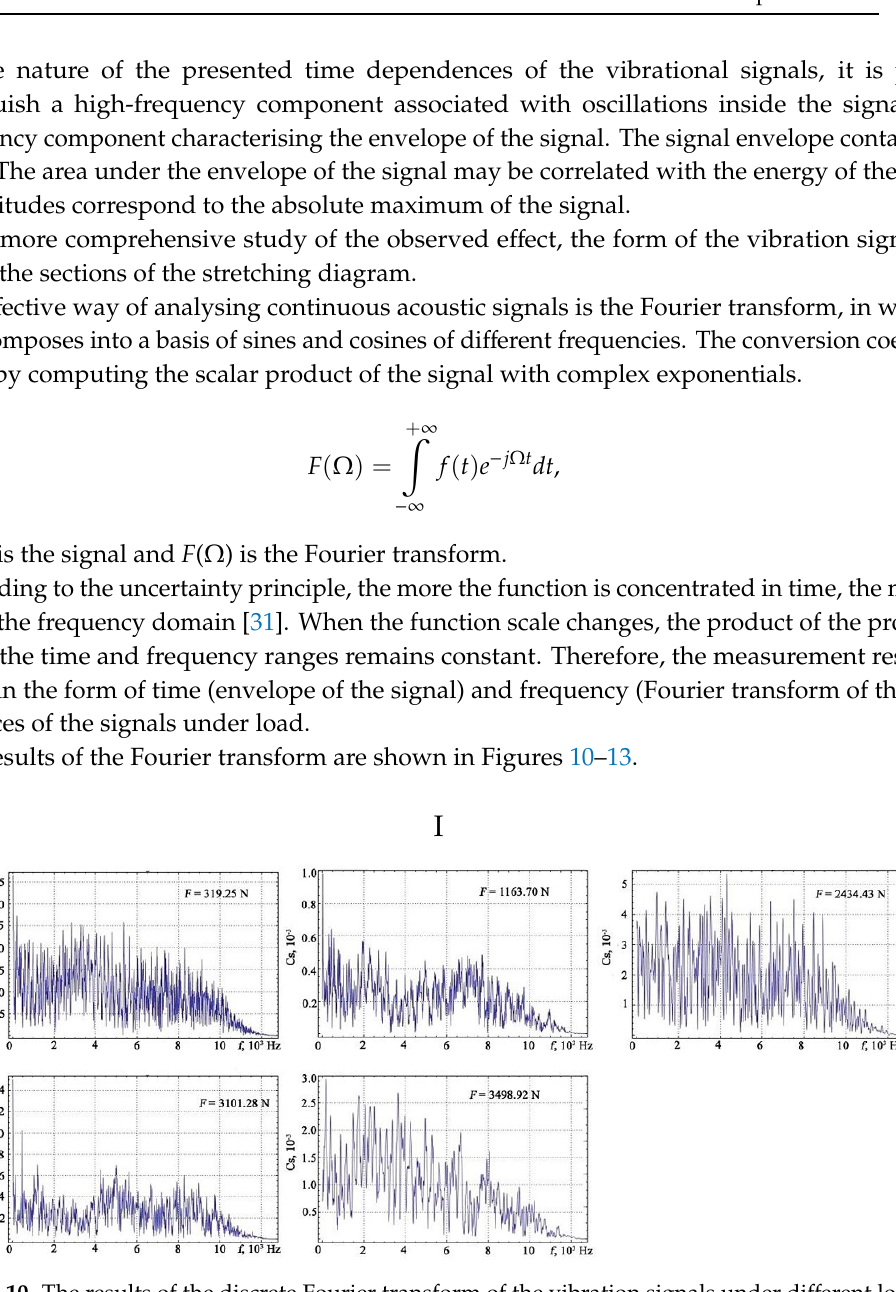
Figure 10. The results of the discrete Fourier transform of the vibration signals under di ff erent loads: I—plot of the elastic region